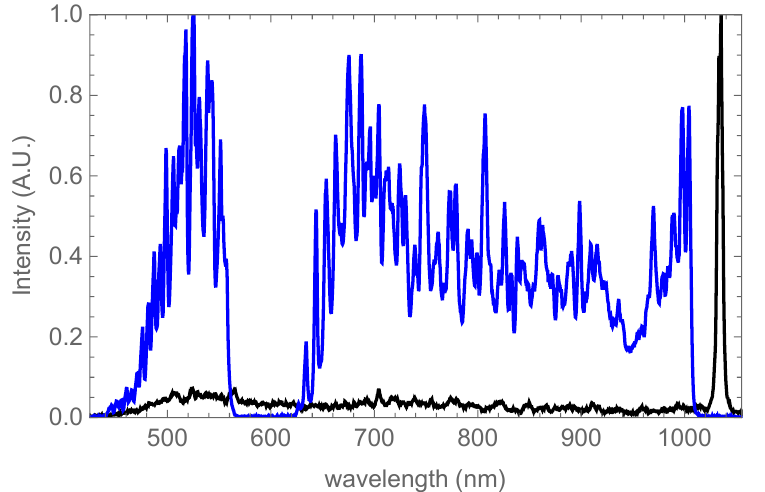
Figure 2. White-light continuum spectrum before (black) and after (blue) spectral filtering. The vertical scale is normalized separately for each